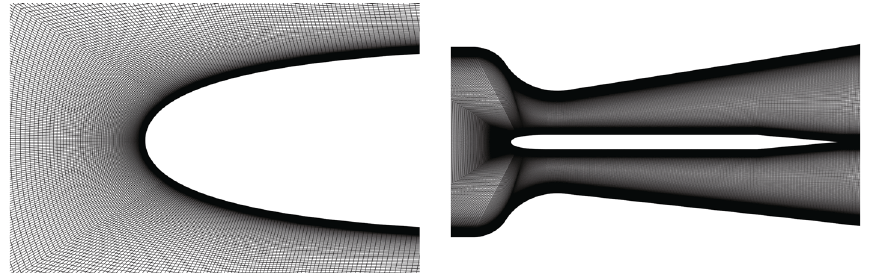
Figure 2: Mesh generation sketch.